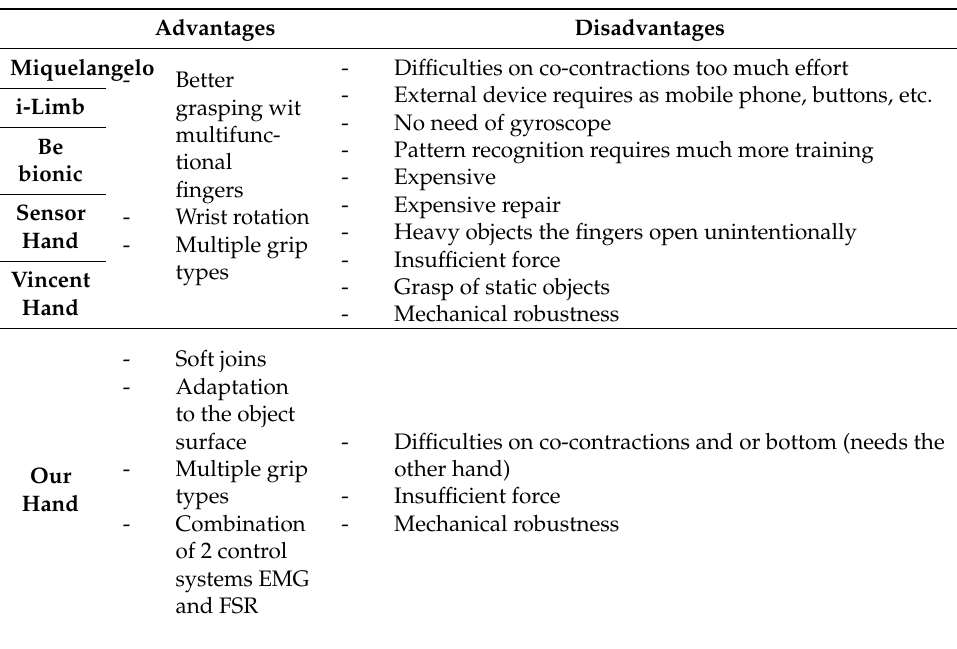
Table 5. Prosthetic hand advantages and